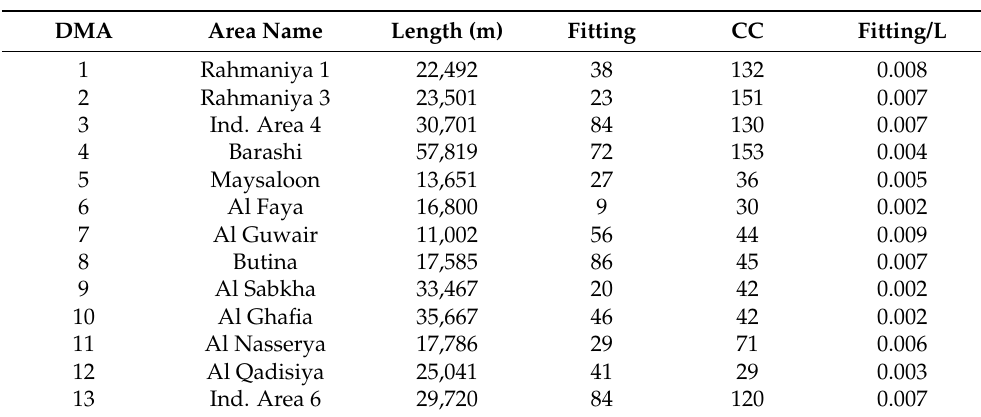
Table 4. Number of